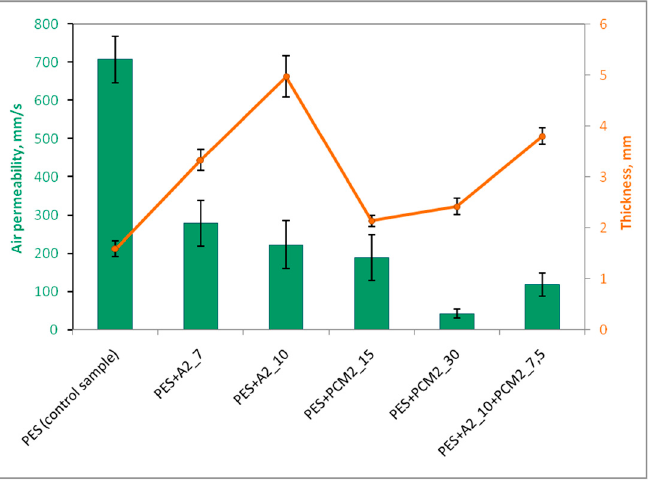
Figure 12. Air permeability of the nonwoven inserts.